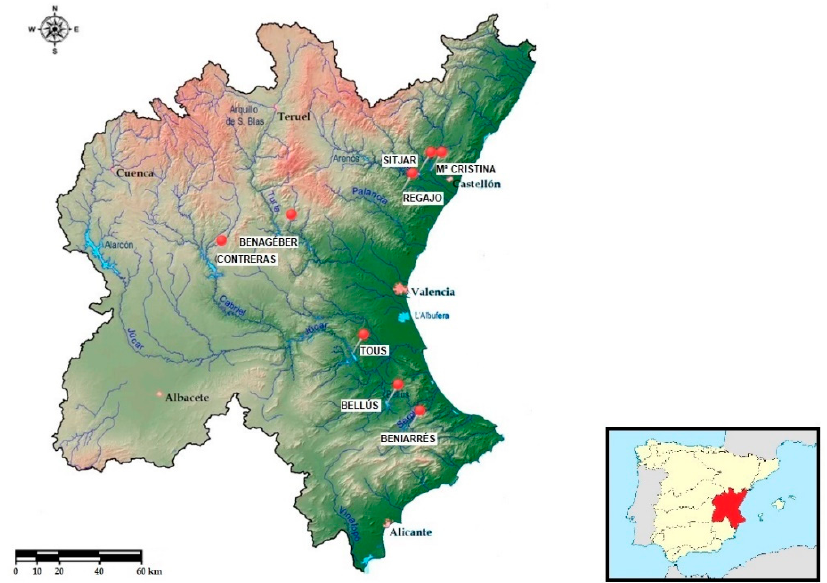
Figure 2. Location of selected reservoirs in the Júcar hydrographic watershed. Modified from [36].